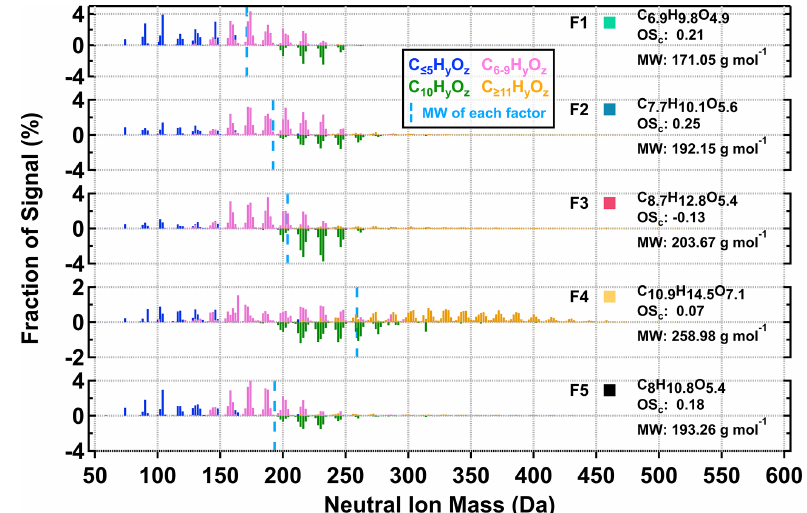
Figure 4. Normalized factor mass spectra of the five sample factors from the 12-factor PMF solution of CHO compounds in α -pinene SOA particles that were formed under two NO x conditions in the OFR. For readability, C 10 H y O z ions are shown as negative values. For each factor mass spectrum, its signal-weighted molecular composition, molecular weight (MW), and oxidation state (OS c ) are shown on the right. Right next to each factor label, the squares are shown in the same color scheme as the factor thermograms in Fig. 3 to indicate different sample factors. The blue dashed line indicates the average MW of each